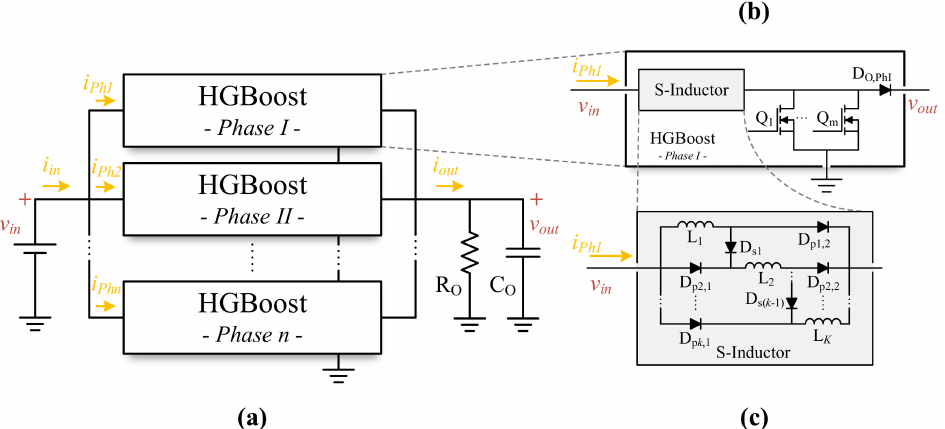
Figure 1. Simplified sketch of the proposed high-gain boost converter: ( a ) General diagram of the n-phase converter; ( b ) Single-phase scheme with m transistors; ( c ) Scheme of the selected switched inductor.